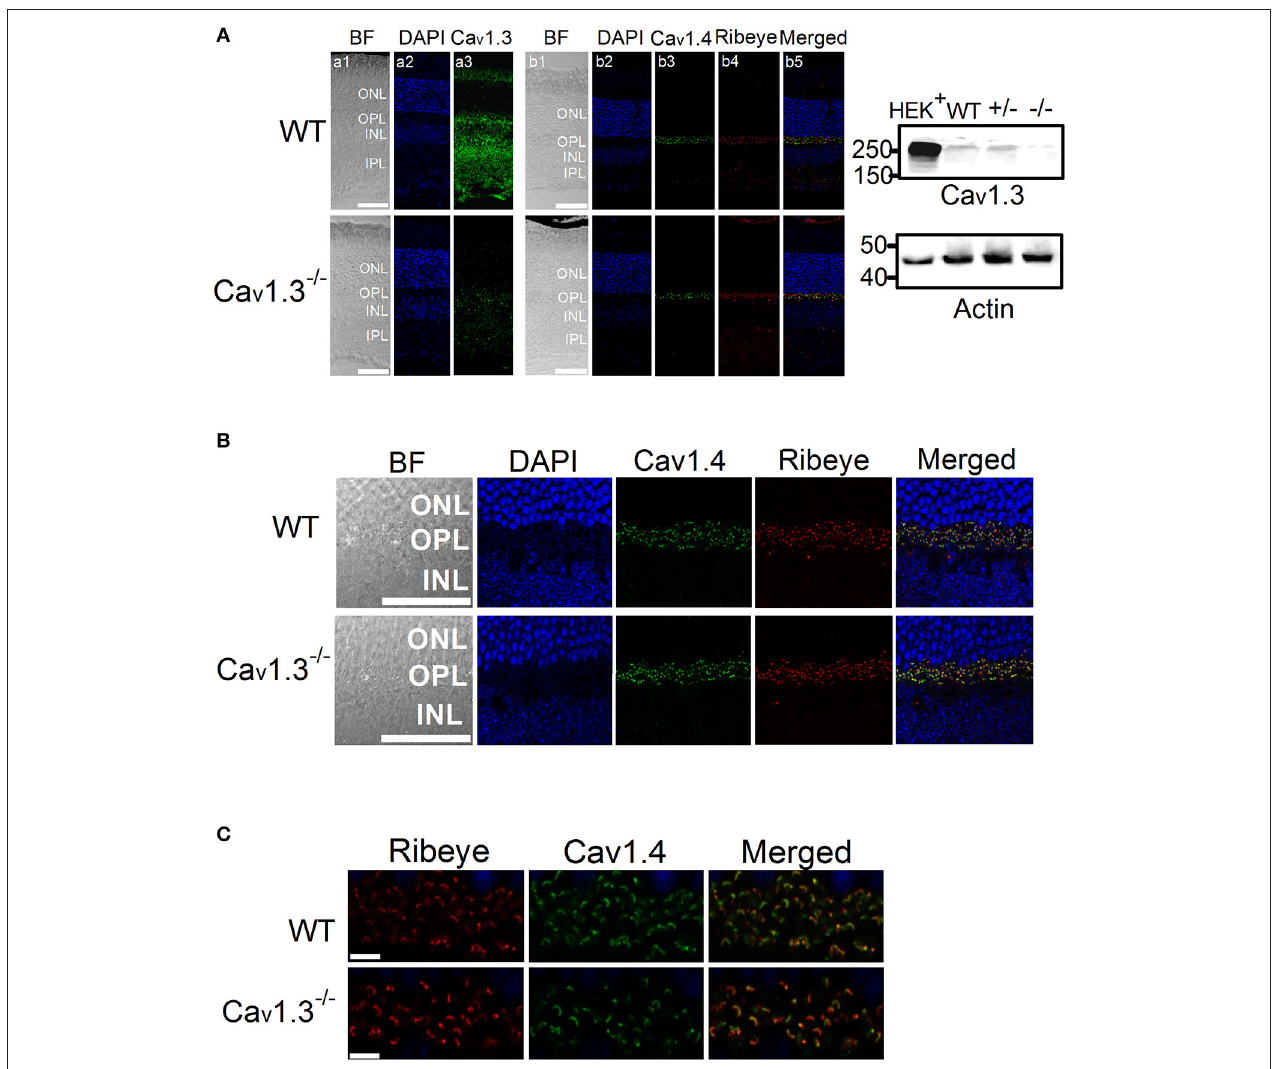
FIGURE 6 | Immunofluorescent changes of Ca v 1.3, Ca v 1.4, and Ribeye in Ca v 1.3 − / − mouse retinas. Ca v 1.3 + / + (WT) and Ca v 1.3 − / − retinal sections (10 µ m) were stained for Ca v 1.3, Ca v 1.4, and Ribeye. (A) Representative images at a lower magnification (20 X) of WT (upper panel) and Ca v 1.3 − / − (lower panel) retinal sections. DAPI stains the cell nucleus. BF: bright field; ONL: outer nuclear layer; OPL: outer plexiform layer; INL: inner nuclear layer; IPL: inner plexiform layer. The scale bar = 50 µ m. Right panel: The Western blots from Ca v 1.3 transfected HEK cells (HEK + ), Ca v 1.3 + / + (WT) retina, Ca v 1.3 + / − retina, and Ca v 1.3 − / − retina show the protein band of Ca v 1.3 at ∼ 250 kD. Actin serves as the loading controls. (B) Representative images at a higher magnification (40 X) of WT and Ca v 1.3 − / − retinal sections stained for Ca v 1.4 and Ribeye. The scale bar = 50 µ m. (C) Fluorescent images focused on the OPL at a higher magnification (80 X) from WT and Ca v 1.3 − / − retinal sections are shown. The scale bar = 5 µ m. The images taken at this magnification were used for statistical analyses ( Table 3